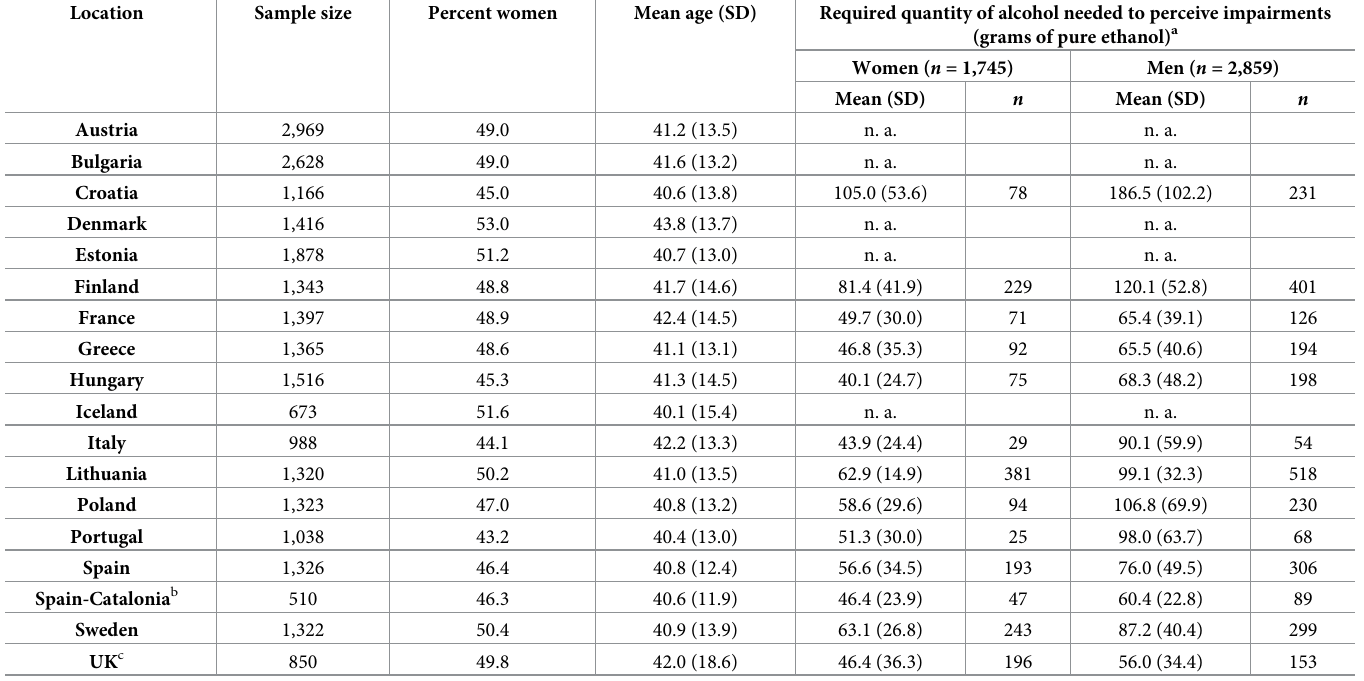
Table 1. Sample size, demographic characteristics and alcohol needed to perceive impairment by gender and location ( n = 25,028).